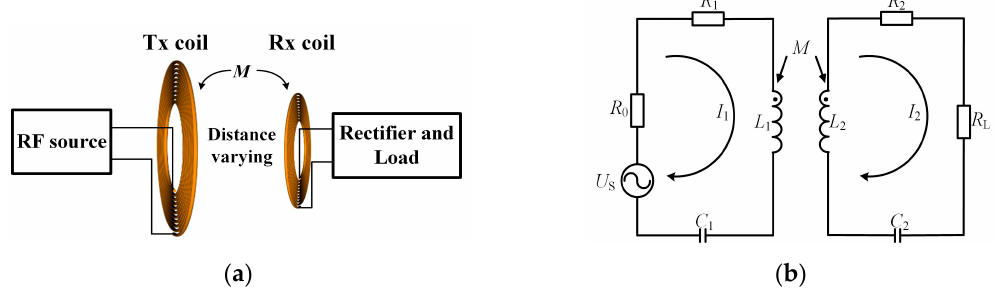
Figure 3. ( a ) Mode and ( b ) equivalent circuit of wireless power transfer (WPT) system.